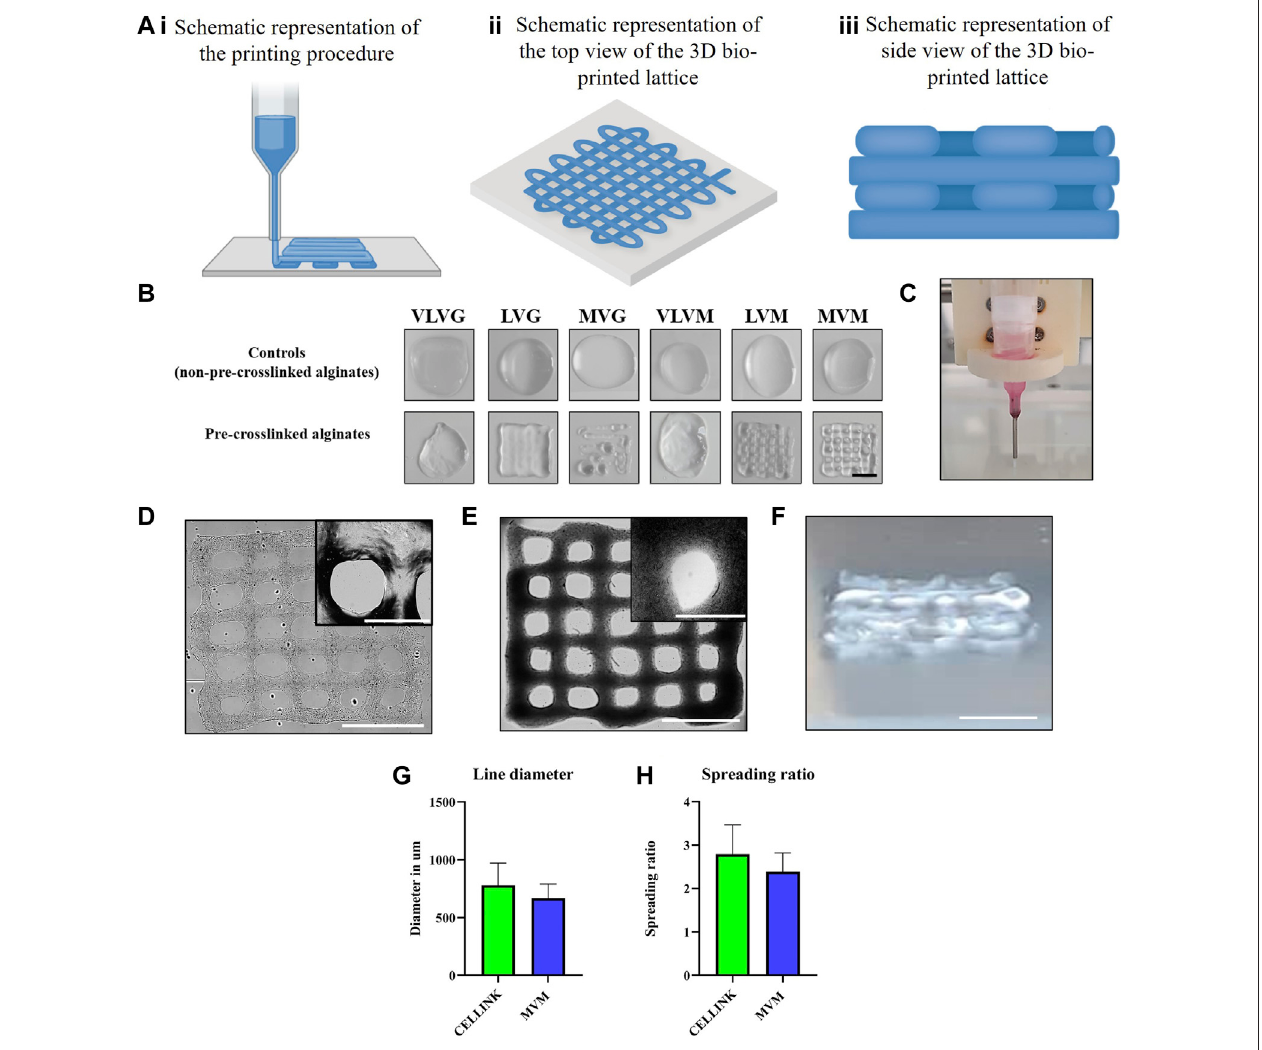
FIGURE5| Effectofpre-crosslinkingonbio-inkprintability.Schematicdesignofthe3Dbio-printedlatticesisillustratedin (Ai – Aiii) withschematicrepresentationof the printing procedure being presented in (Ai) , schematic representation of the top view of the bio-printed lattice presented in (Aii) and the side view of the bio-printed lattice consisting of 4 layers is schematically represented in (Aiii) . Low viscosity alginates were 3D bio-printed in a shape of a lattice and imaged (B) . 30G PTFE lined needle was used during the bio-printing process (C) . Bio-printed pre-crosslinked MVM alginate lattice at 10x magni fi cation and 40x magni fi cation, scalebars represent 1000 µm and 3,000 µm respectively. (D) , bio-printed CELLINK positive control lattice at 10x magni fi cation and 40x magni fi cation, scalebars represent 1000 µm and 3000 µm respectively (E) . Photograph of the side view of the bio-printed lattice is displayed in (F) , scalebar represent 1000 µm. Line diameters were calculated from (D) and (E) and are displayed in (G) . Spreading ratio was calculated by dividing line diameter by the internal needle diameter (280 µm) (H) .